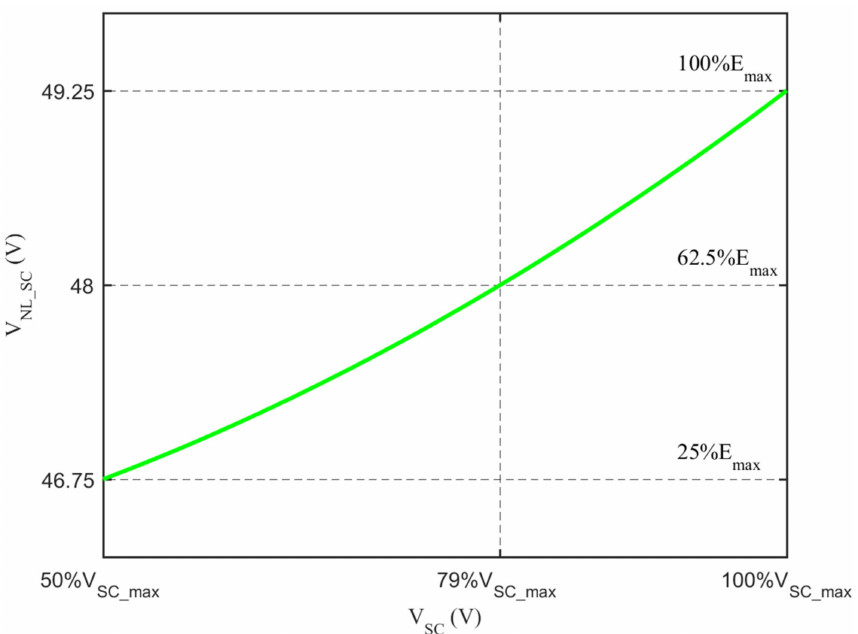
Figure 5. Supercapacitor threshold voltage as a function of supercapacitor voltage based on (11). Figure 6 shows the dribbling supercapacitor I vs. V curve at supercapacitor voltages